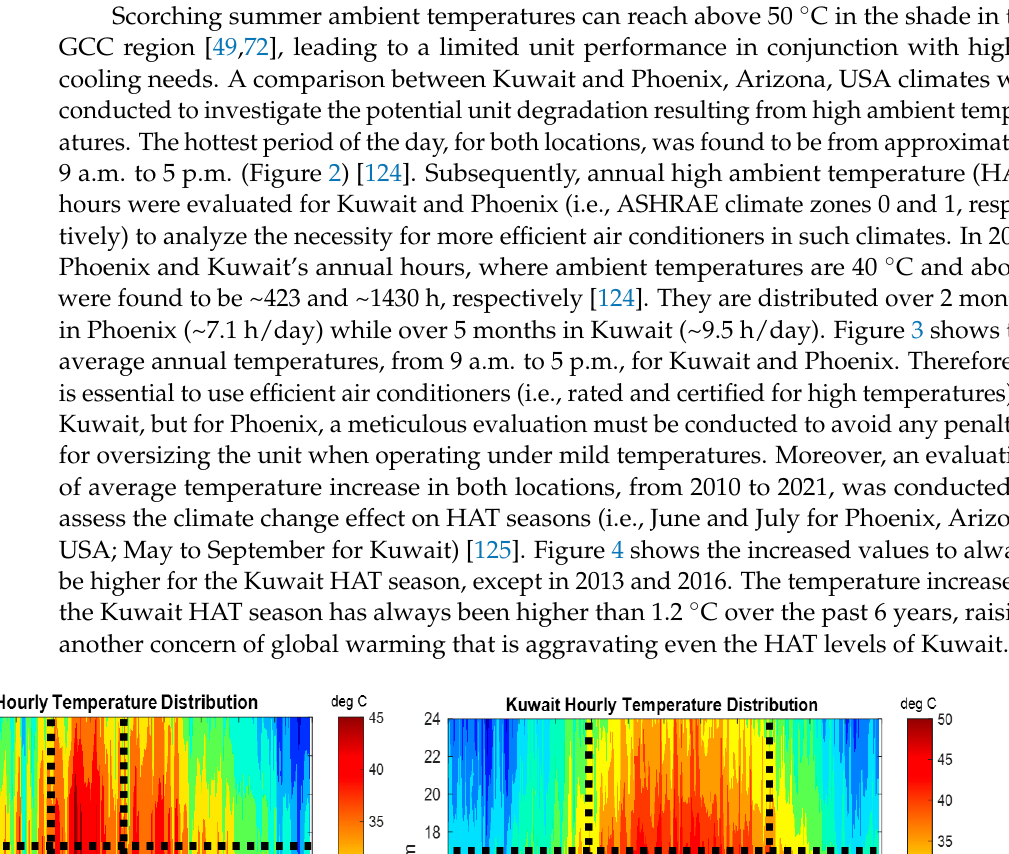
Figure 3. Annual high ambient temperature (HAT), averaged from 9 a.m. to 5 p.m., for Kuwait and Phoenix, Arizona, USA [124]. Figure 4. Average temperature increase for Kuwait and Phoenix, Arizona, USA with respect to the average temperatures for the period from 1981 to 2010 [125].